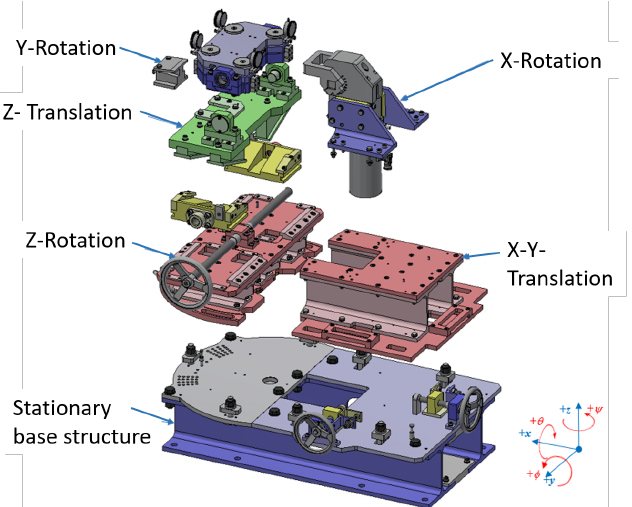
Figure 12. Modular design of the test rig assembly on the example of the LM cask